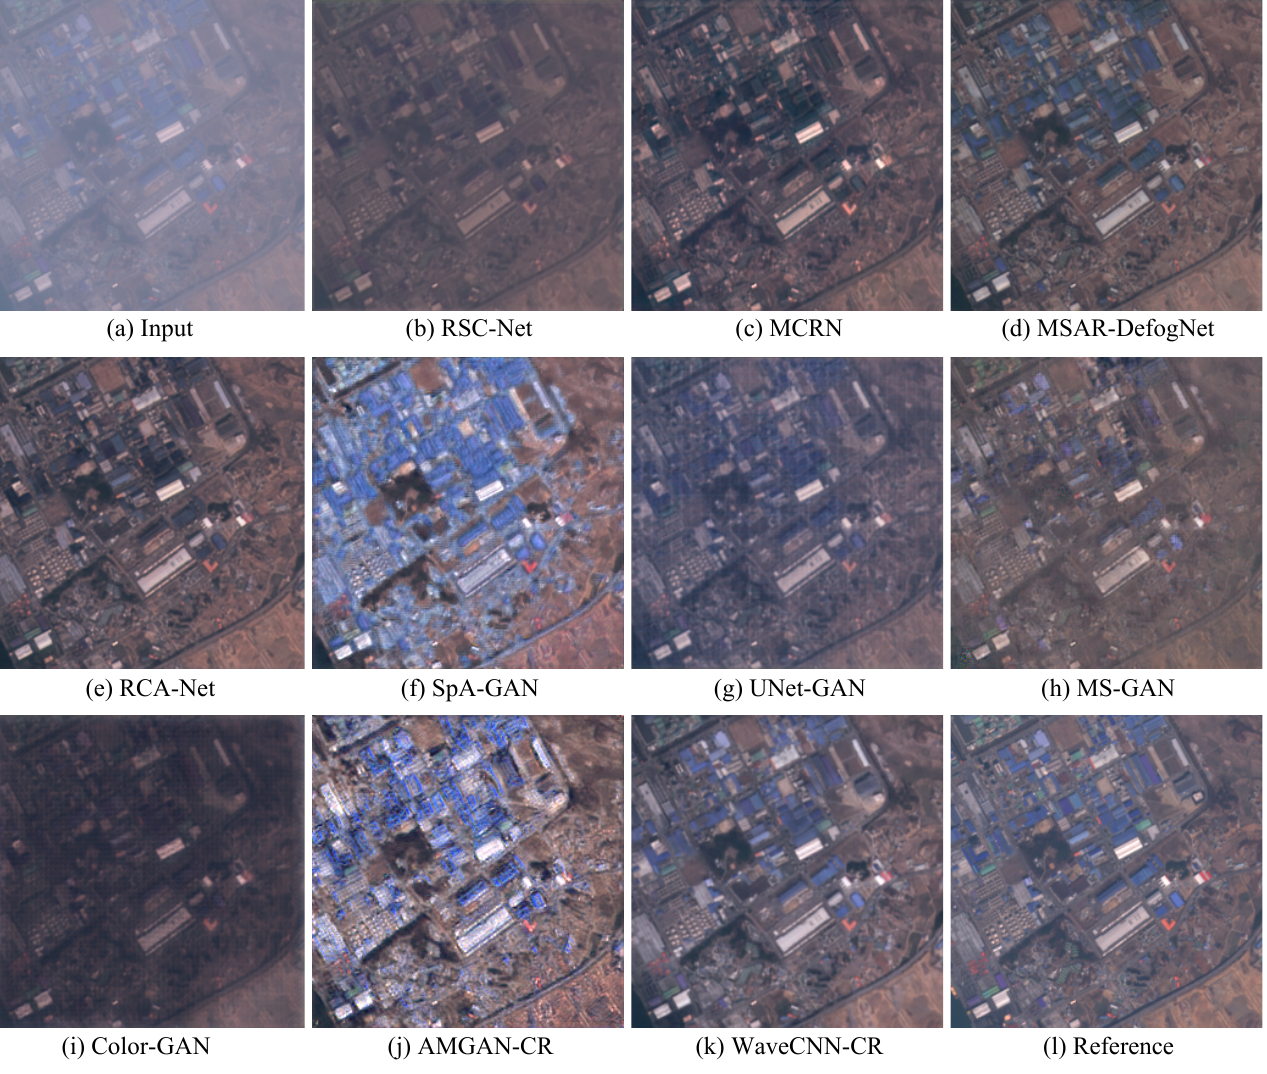
Figure 7. Visual comparisons on the WHUS2-CR dataset: ( a ) input cloudy image; ( b – k ) results of